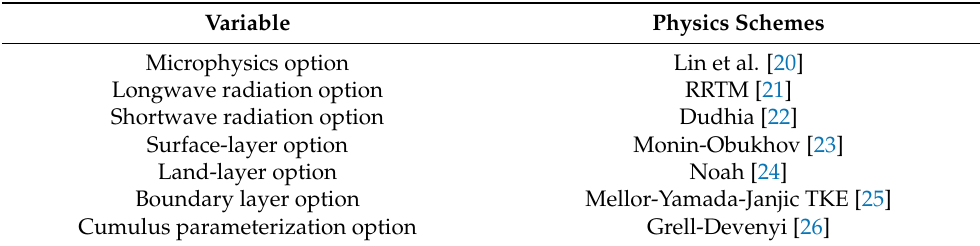
Figure 3. The scope and topography in the WRF model. ( a ) the three nested domains and ( b ) the innermost domain. The white dot represents the location of the observation site. Table 3. The physical parameterization schemes in the WRF model.